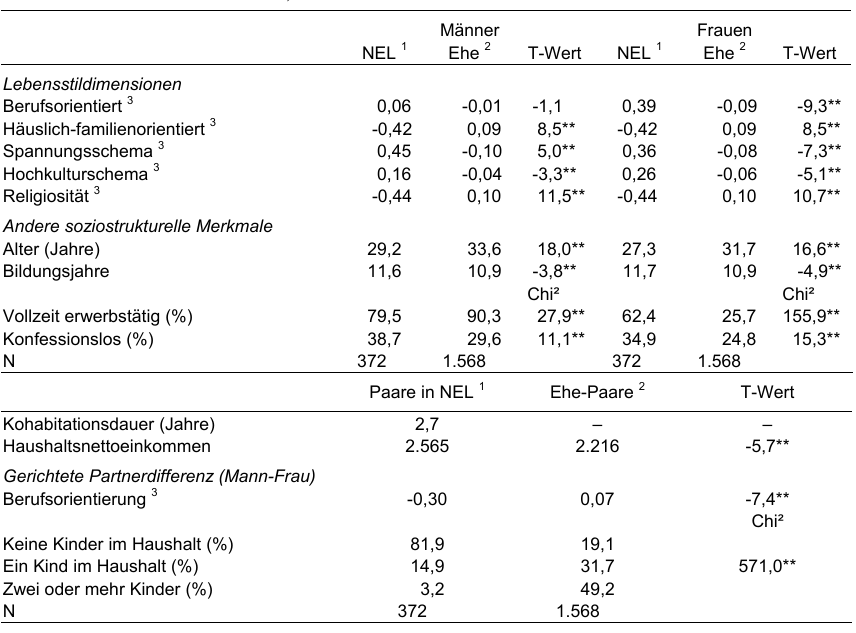
Tabelle 3: Variablenbeschreibung und vergleichende deskriptive Statistik (Personen in Ehen und nichtehelichen Lebensgemeinschaften, Anteils- bzw.